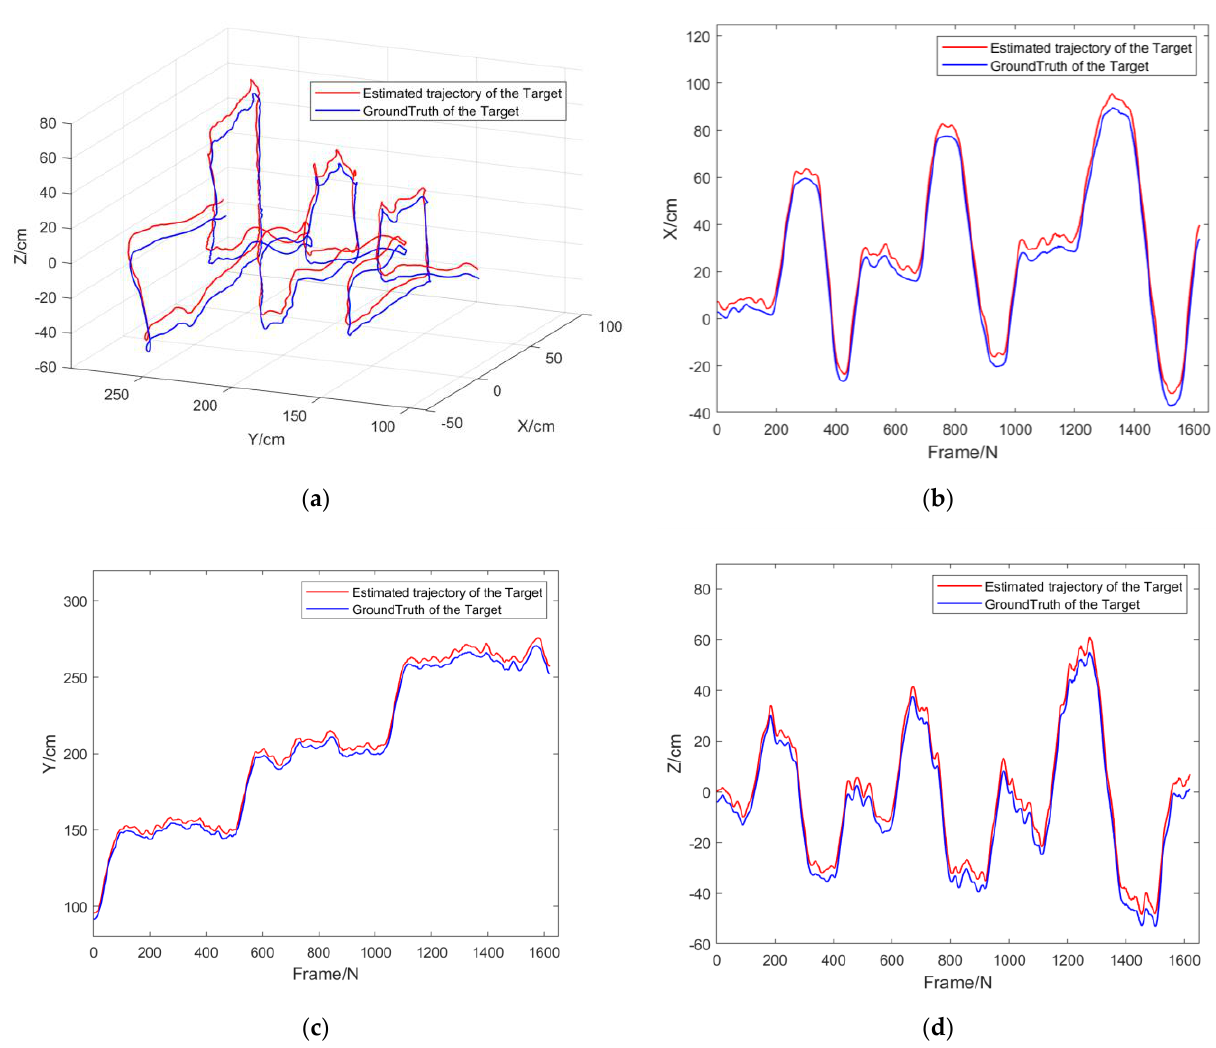
Figure 13. ( a ) Target tracking results of experiment 2: Comparison of motion trajectories under different depth values, ( b ) trajectory comparison in x-axis, ( c ) trajectory comparison in y trajectory comparison in x axis, ( d ) trajectory comparison in z-axis.